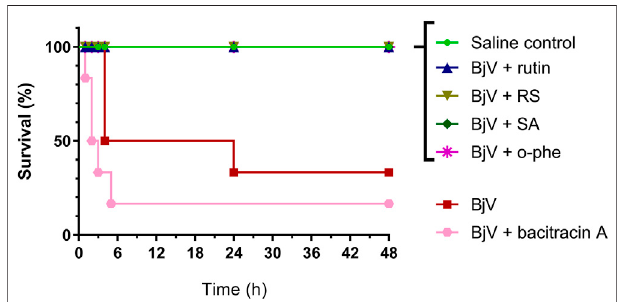
FIGURE 13 | Survival curves of mice during 48 h after the injection of saline, BjV,BjV +rutin, BjV+ RS,BjV +SA, BjV+ o-phe andBjV + bacitracin A (BjV dose: 3×LD 50 ). Log-rank test was used, and survival curves showed signi fi cant difference ( p = 0.005). Data were expressed as percentage of survival ( n = 3 –